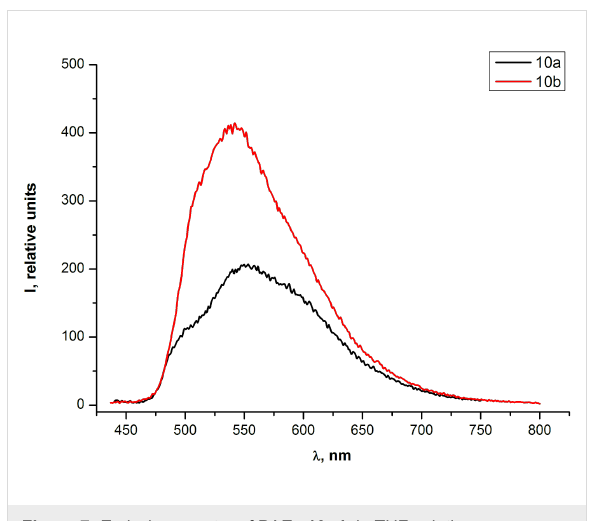
Figure 7: Emission spectra of PAEs 10a,b in THF